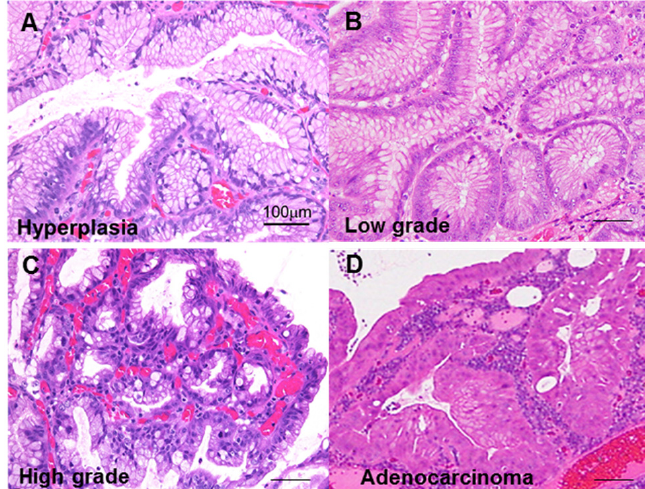
Figure 1. Atypia in hyperplastic polyps. ( A ) Hyperplastic polyp without atypia. ( B ) Low-grade atypia, notable mild nuclear swelling. ( C ) High-grade atypia, notable moderate to marked nuclear swelling, nuclear pseudostratification, and decrease in mucus production. ( D ) Carcinoma in hy- perplastic polyp (well-differentiated tubular adenocarcinoma), marked nuclear swelling, nuclear pseudostratification, decrease in mucus production, and structural atypia. Scale bar, 100 µ m.